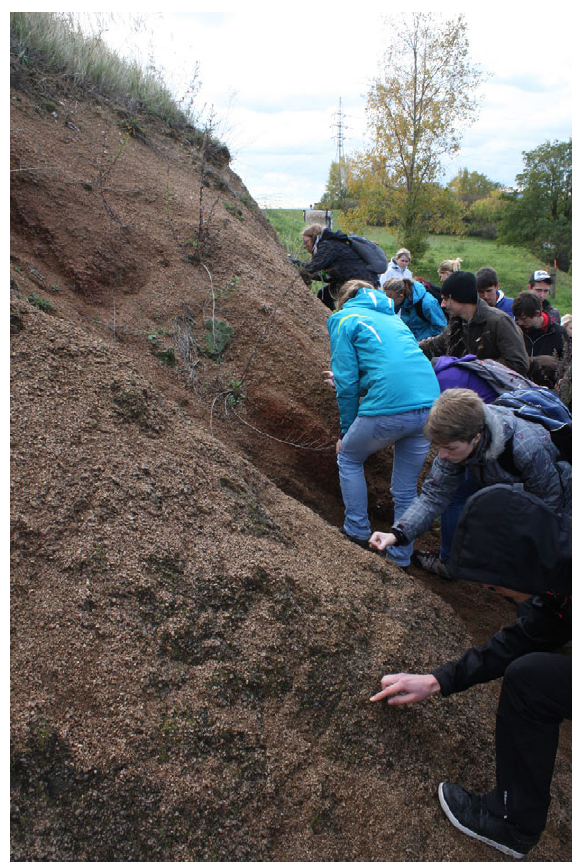
Fig. 6. The communication cutting of jedovnická street which displays the Brno Massif´s granodiorites has a big educational potential (Photo: A. Bajer,